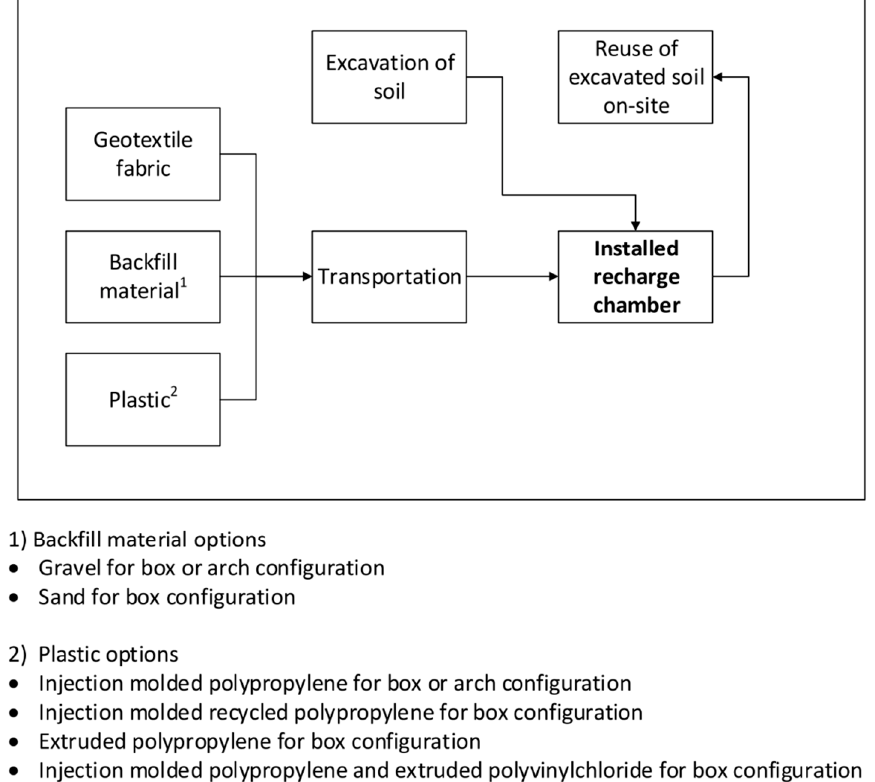
Figure 2. System diagram for cradle-to-gate LCA of box and arch recharge chambers showing options for plastic and backfill. Boxes represent cradle-to-gate processes and arrows represent material flows.